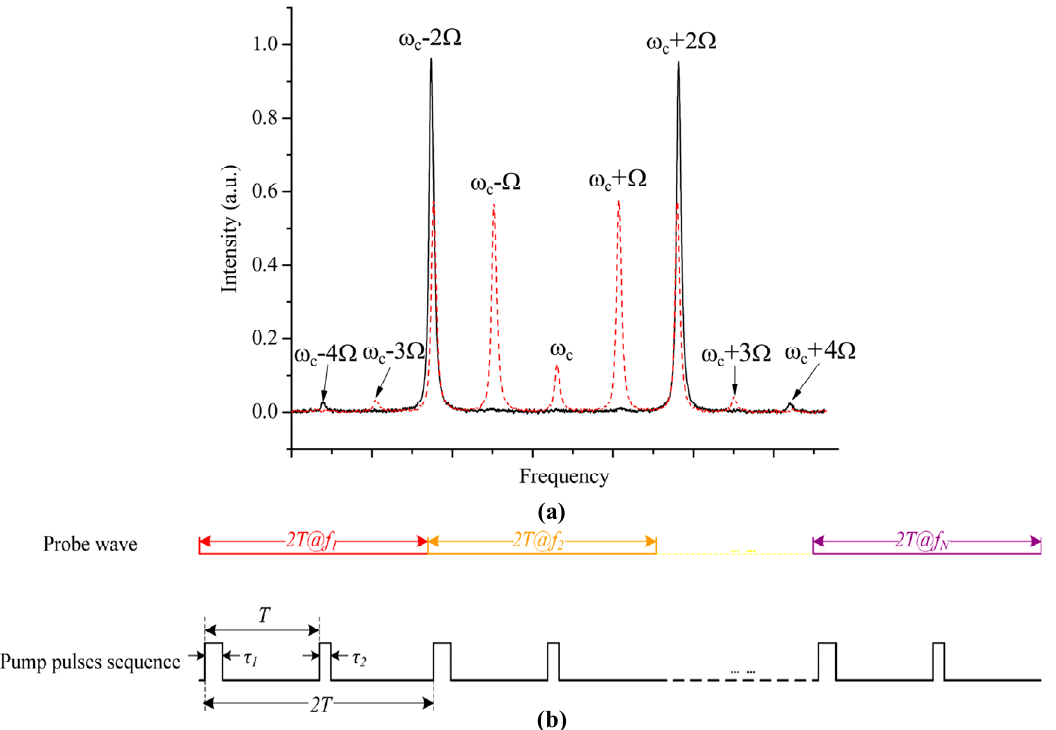
Figure 5. The improved OFA-based fast BOTDA scheme with the SOSM and DPP techniques [32]. ( a ) The frequency relationship of the SOSM and ( b ) the time sequence of the DPP pump wave and the OFA-probe wave.